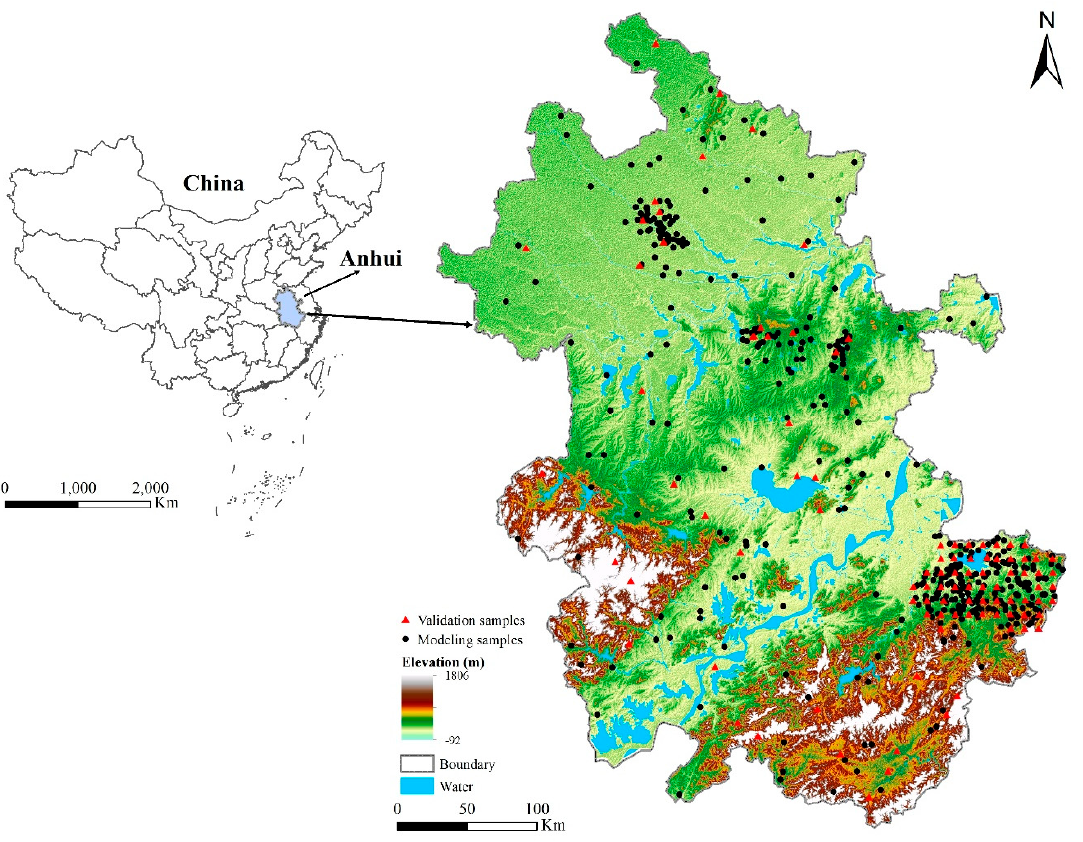
Figure 1. Map of the study area (Anhui Province) and soil samples.